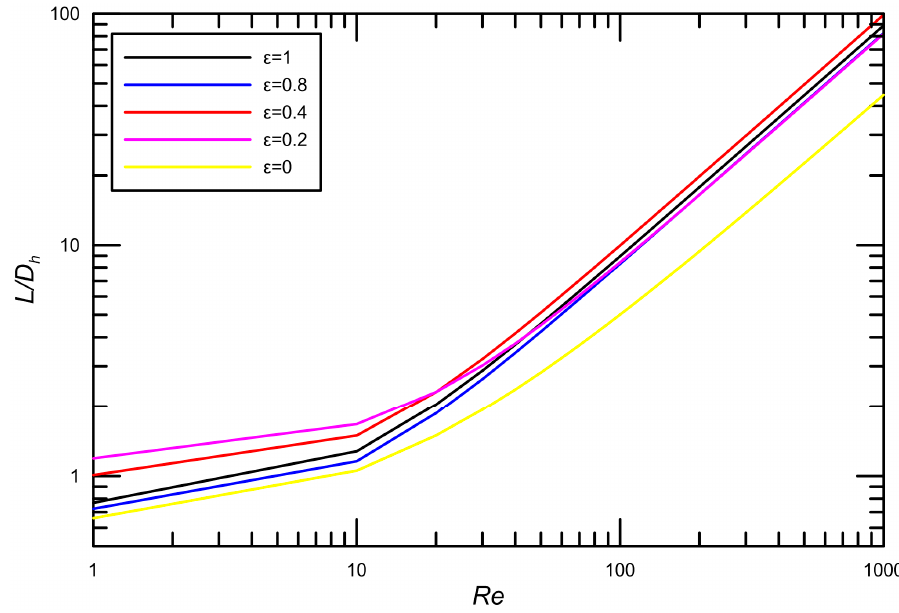
L D with Re for different aspect ratios. Figure 8. Variation of L / D h with Re for different aspect ratios. h